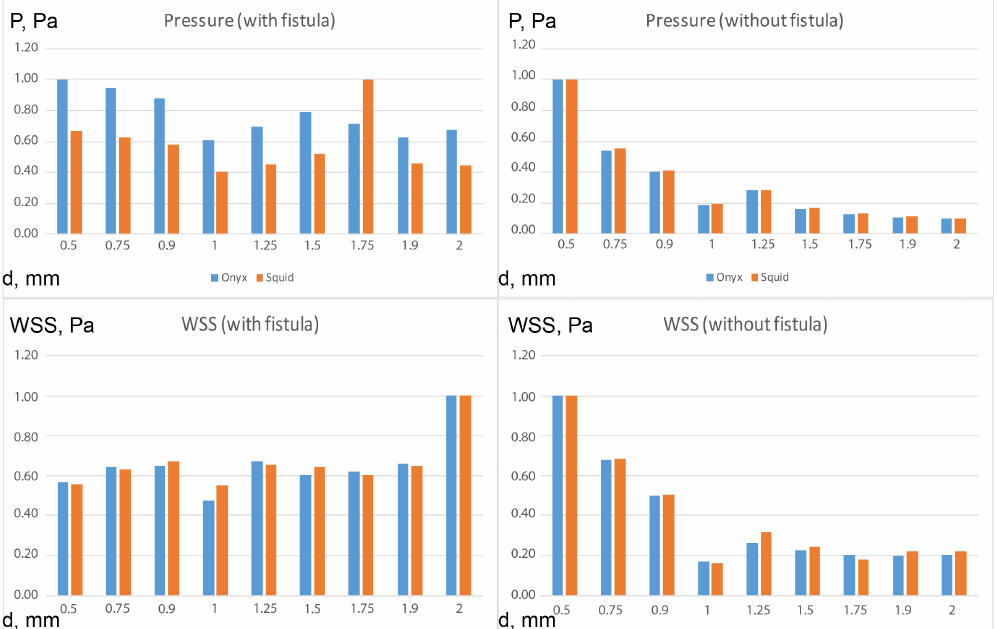
Figure 12. Pressure and WSS results of numerical calculations in the configuration with and without fistula for all considered vessel radii.